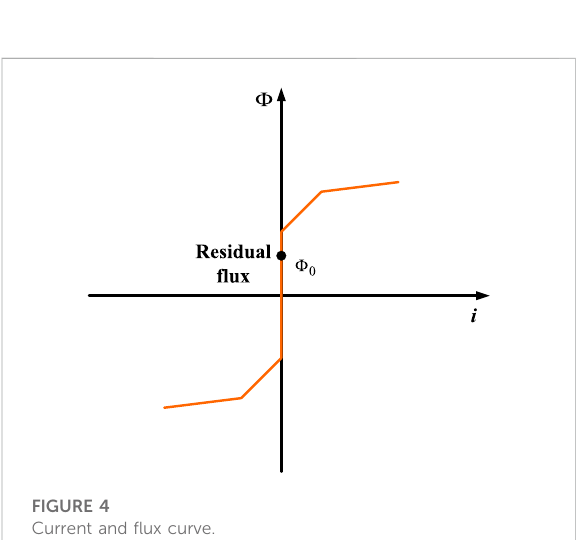
FIGURE 4 Current and fl ux curve.